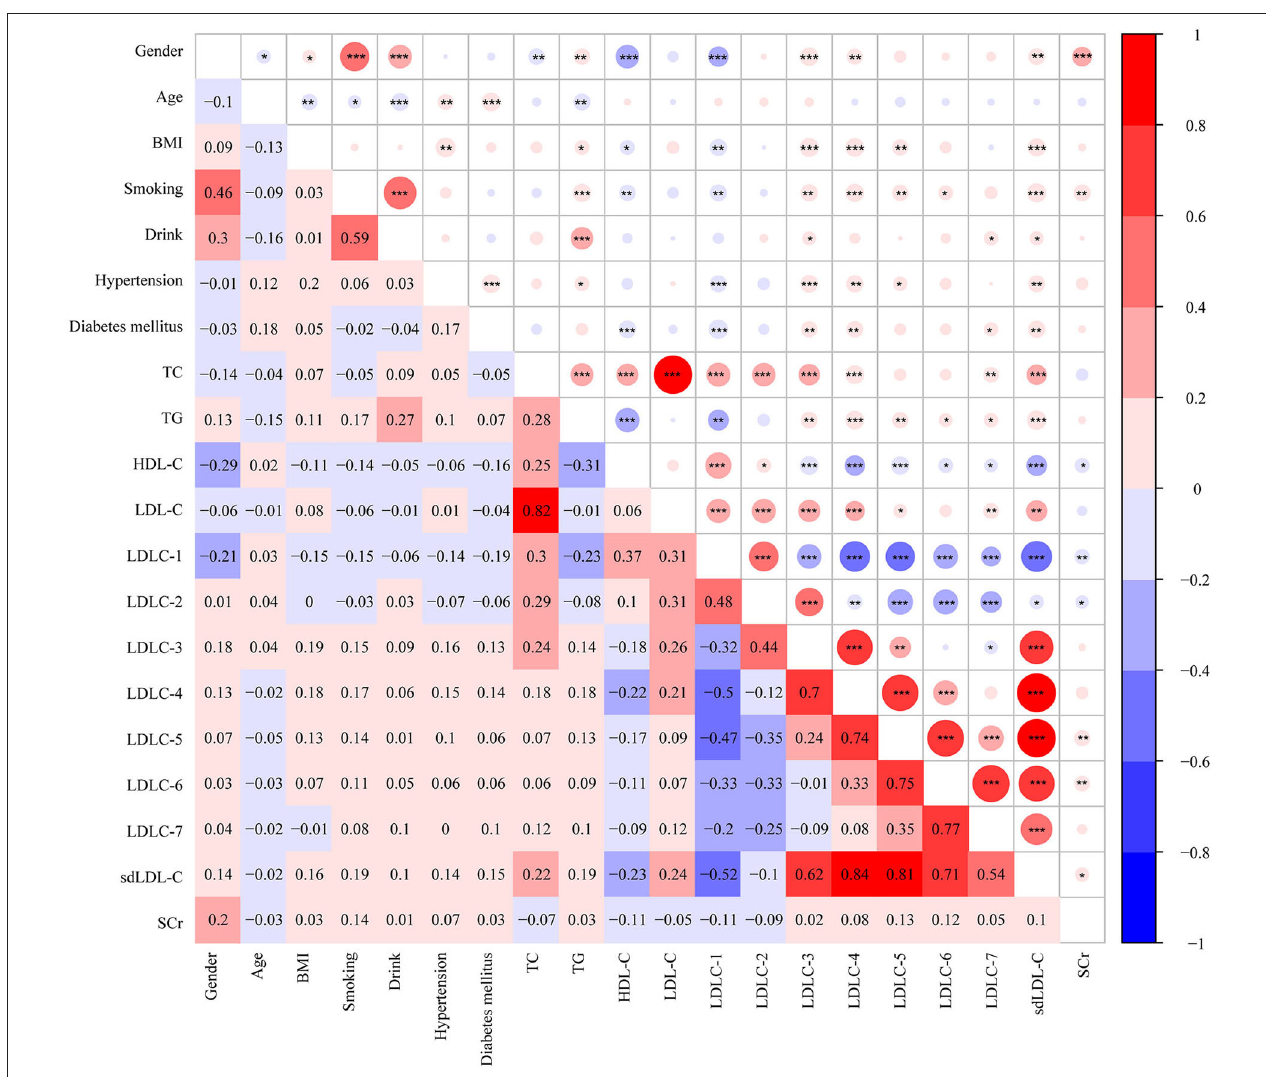
FIGURE 4 | Heatmap showing the correlation among clinical characters and blood markers. The value in grids is Pearson correlation coefficient (Pearson r ), which is also marked by colors. * P < 0.05, ** P < 0.01, *** P < 0.001. BMI, body weight index; TC, total cholesterol; TG, triglyceride, HDL-C, high-density lipoprotein cholesterol; LDL-C, low-density lipoprotein cholesterol; sdLDL-C, small and dense LDL-C; SCr, serum